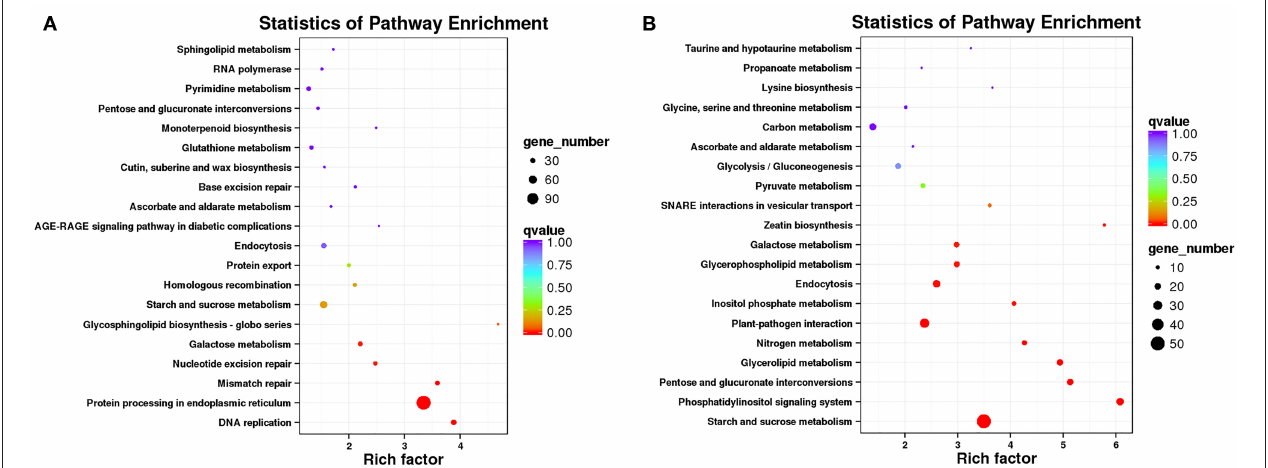
FIGURE 6 | Top 20 significantly enriched Kyoto Encyclopedia of Genes and Genomes (KEGG) pathways. “Rich factor” indicates a high degree of enrichment. Dot size indicates how many DEGs are annotated to the pathway. The colors red, green, and blue indicate low, medium, and high expression patterns of genes, respectively.